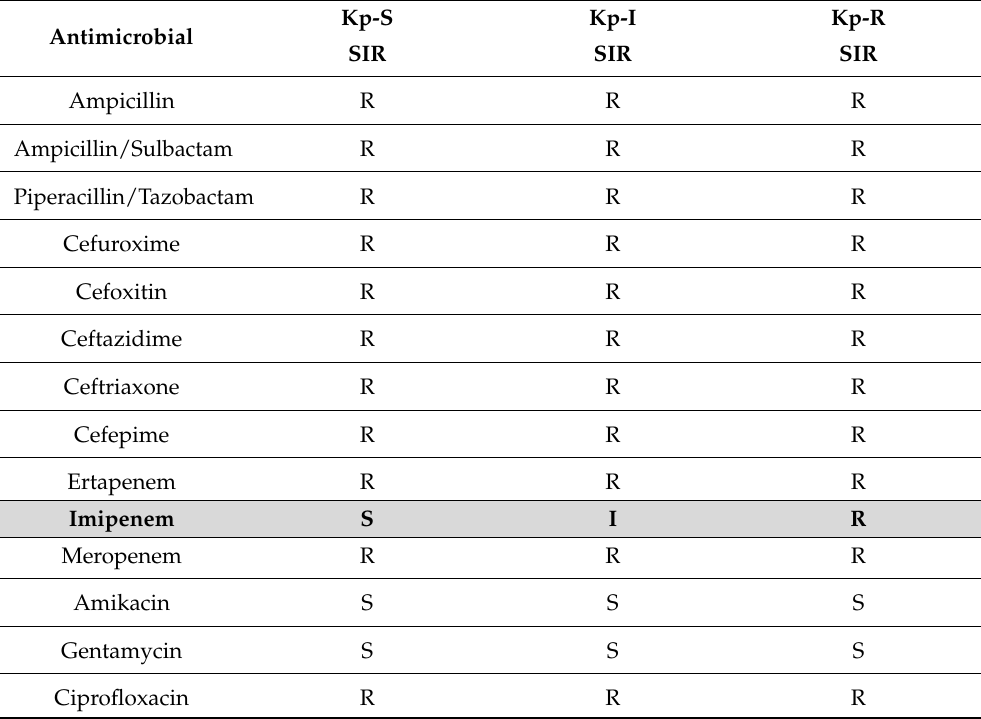
Table 2. Antibiotic susceptibility profiles of K. pneumoniae clinical isolate strains isolated from catheter tip (Kp-S and Kp-I) and urine sample